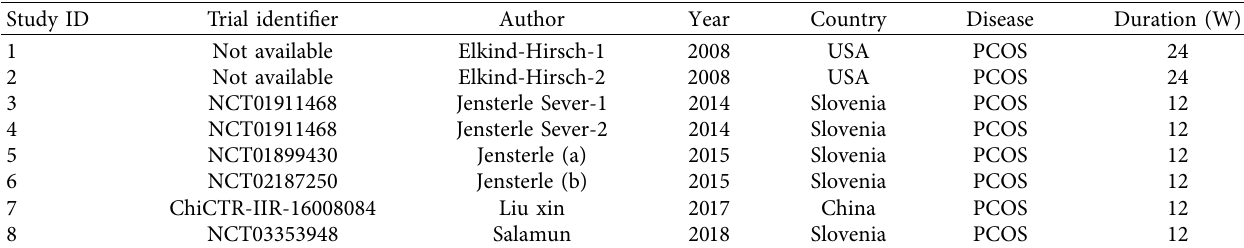
Figure 1: PRISMA flow diagram showing the process of studies Table 1: Characteristics of the studies included in the meta-analysis.